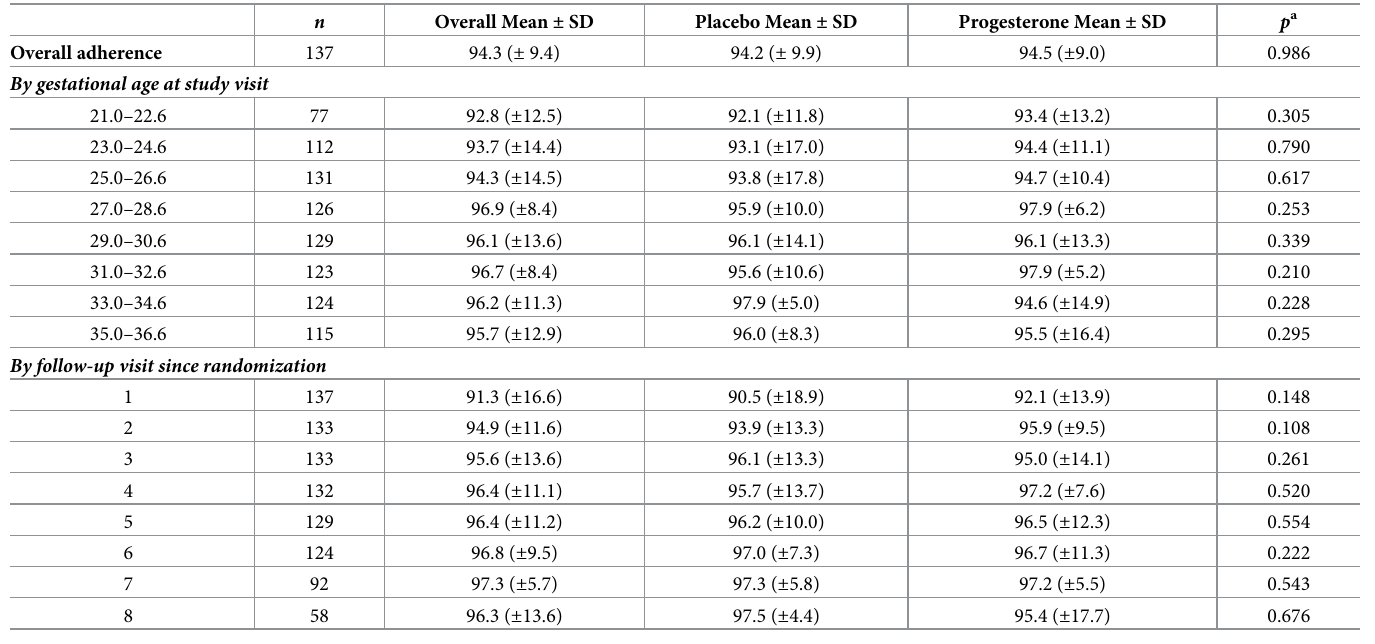
Table 2. Adherence based on dye stain assay of returned applicators by gestational age at study visit and by visits since randomization.